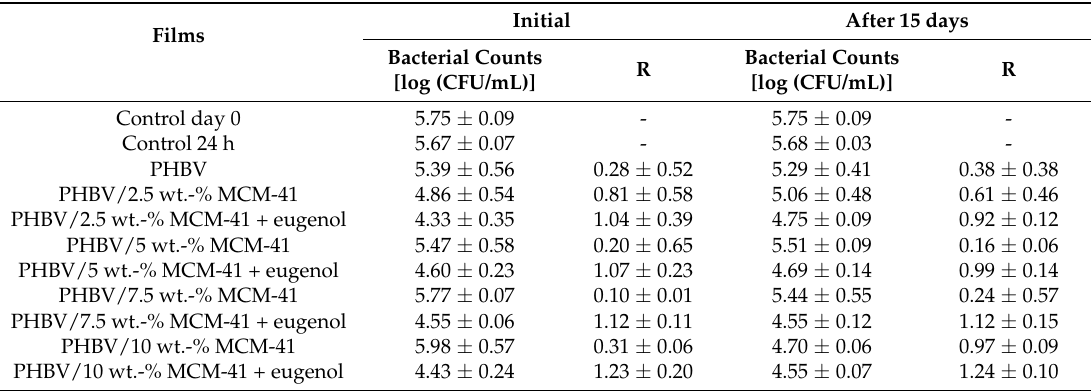
Table 6. Antibacterial activity against Staphylococcus aureus ( S. aureus ) in the open system for the electrospun films of poly(3-hydroxybutyrate- co -3-hydroxyvalerate) (PHBV) and PHBV/Mobil Composition of Matter (MCM)-41 with